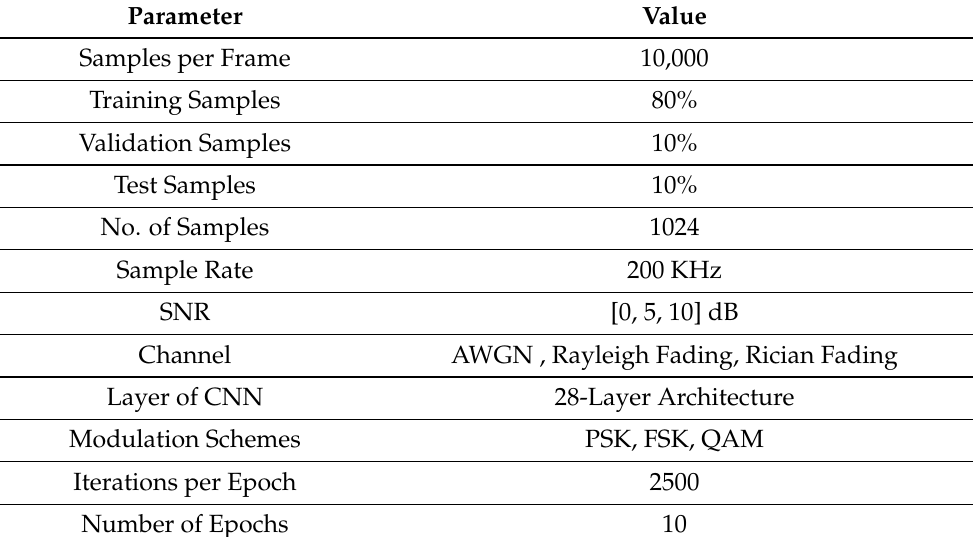
Table 2. Simulation